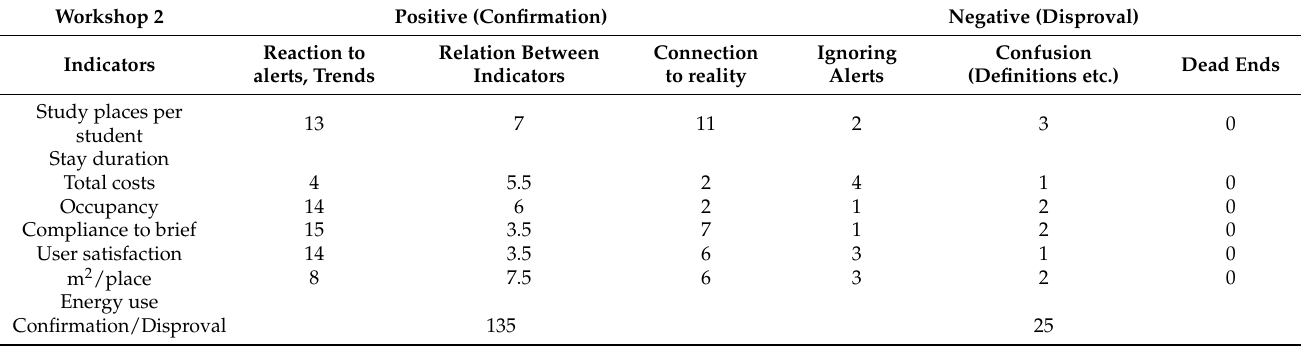
Table A2. Positive and negative interactions of users with the dashboard in workshop 2